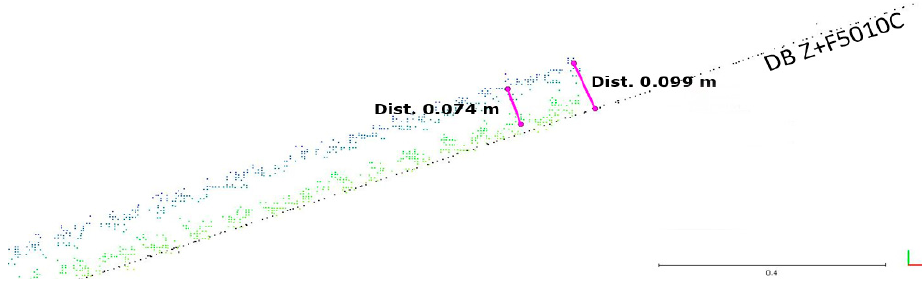
Figure 24. Leica Pegasus Backpack, detail of a horizontal slice of data shown in Figure 23 (reference data in black, compared data in colour).